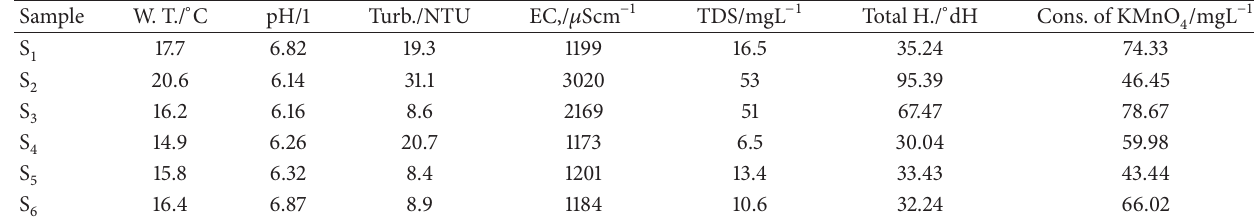
Table 2: Some physicochemical parameters determined in river